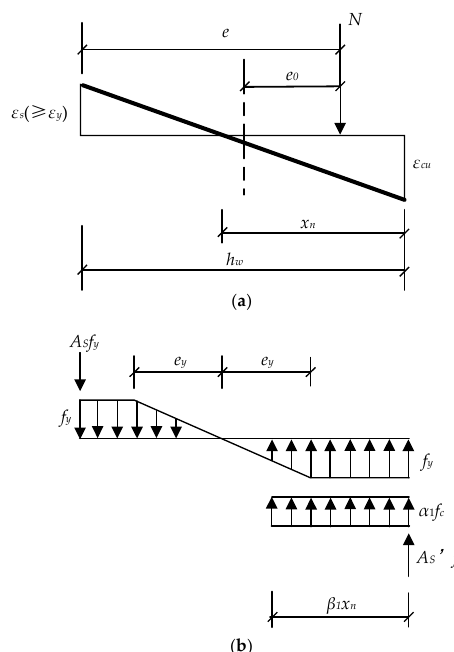
Figure 8. Stress and strain distribution of cross section for the large eccentric SC wall. ( a ) Strain distribution of the cross section; ( b ) Stress distribution of the cross section.